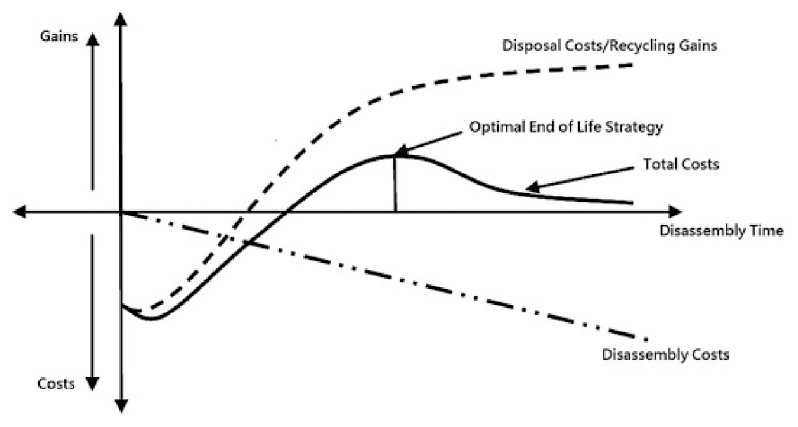
Figure 1. Total costs’ function in DFD [6].